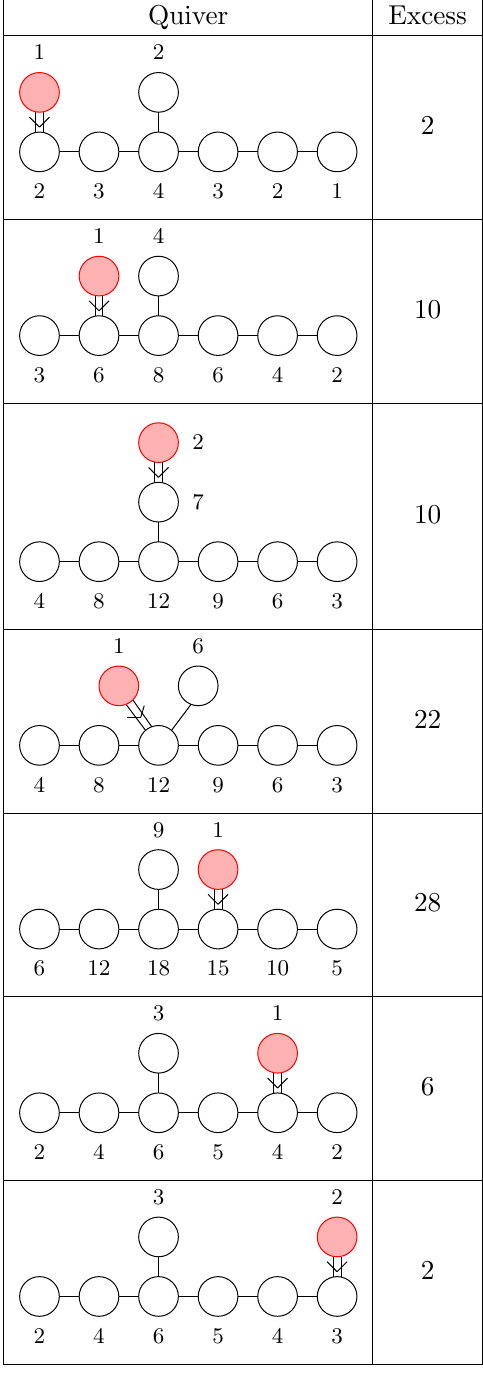
Table 20 . Exotic minimally unbalanced quivers of E 7 -type with outward double laced